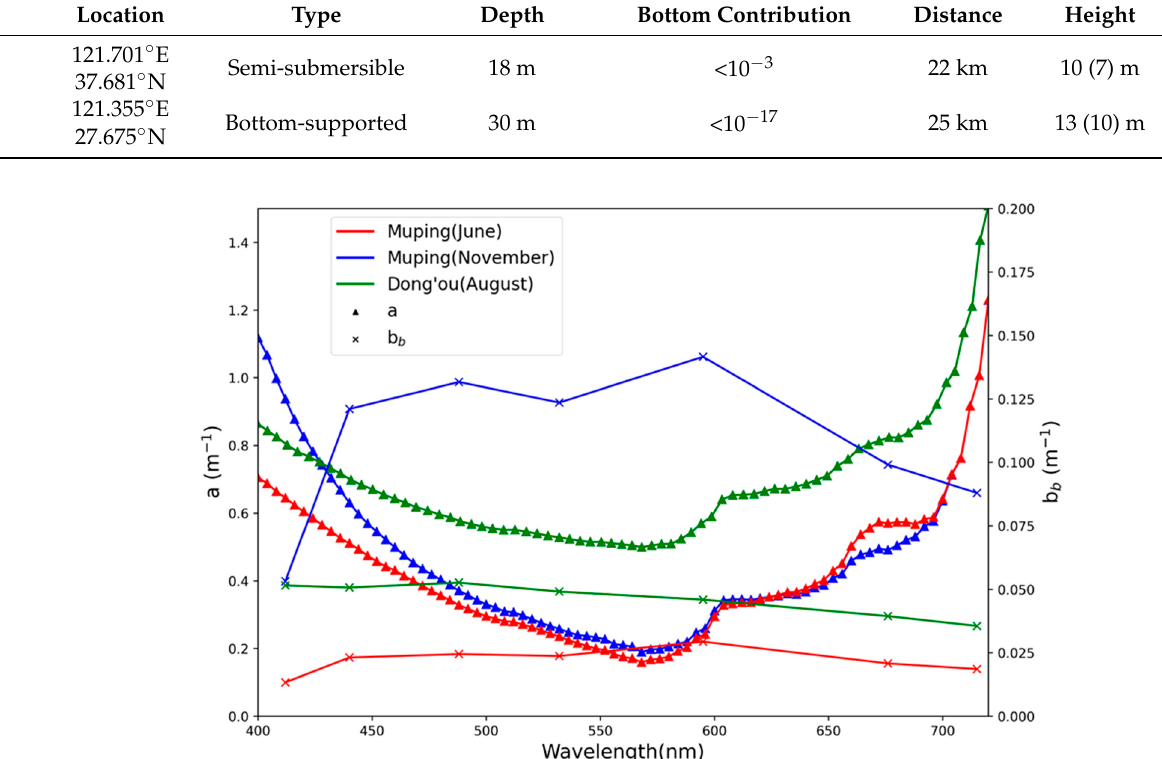
Figure 3. In situ-measured absorption coefficient (triangle, left y -axis) and backscattering coefficient (star, right y -axis) in June (red line) and November (blue line) at the Muping site and in August (green line) at the Dong’ou site.